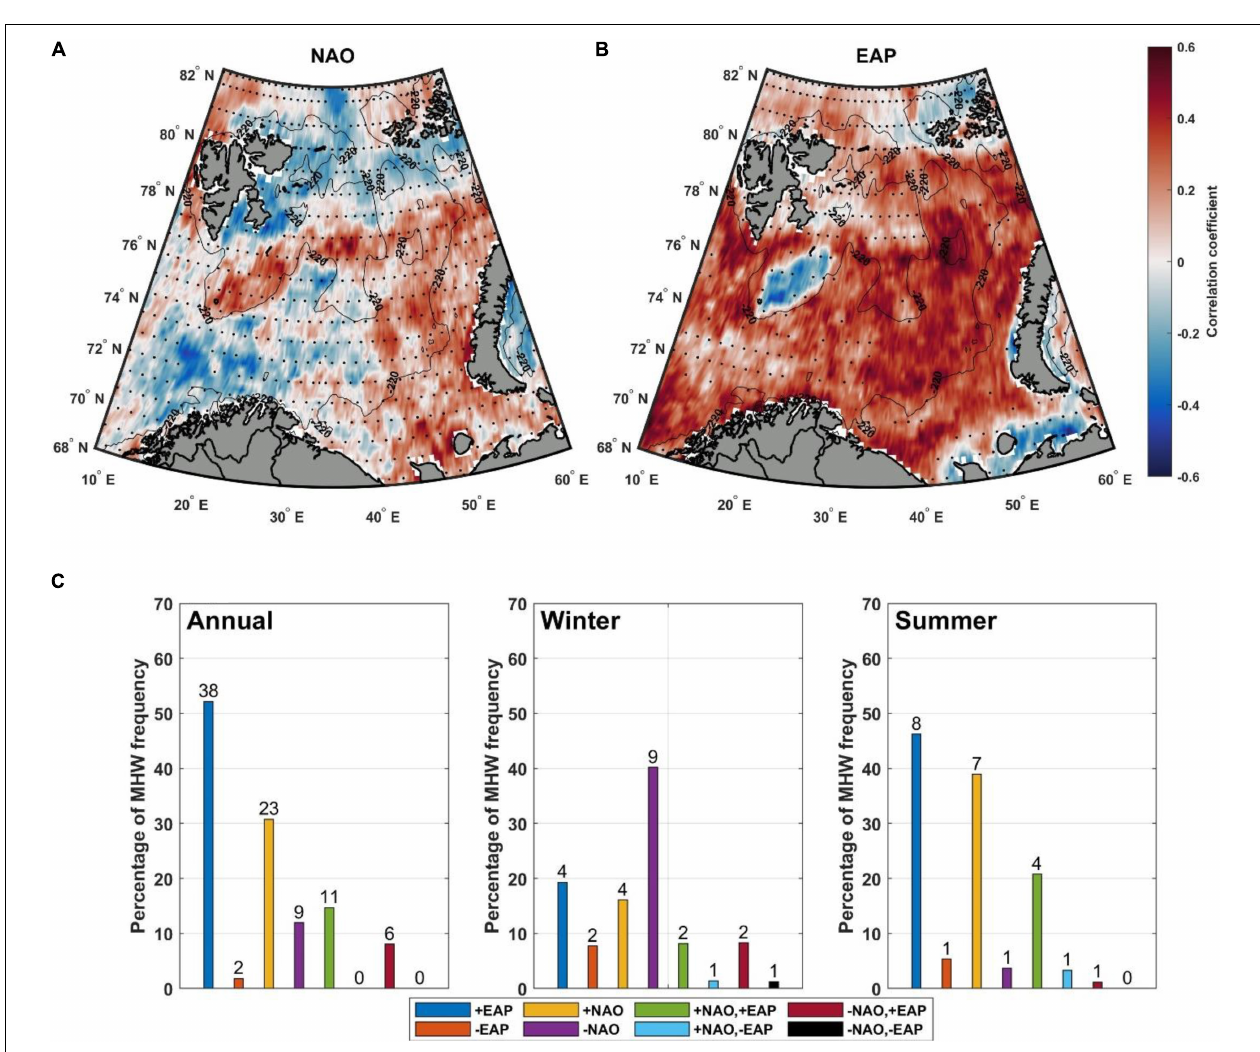
FIGURE 7 | Correlation coefficients between MHW frequency and two major climate modes: (A) NAO, (B) EAP. Stippled regions indicate that the correlations are statistically non-significant at the 95% confidence level ( p > 0.05). (C) The percentage of MHW occurrences that coincide with climate modes for the entire year, winter, and summer. The numbers above the bars represent the total number of